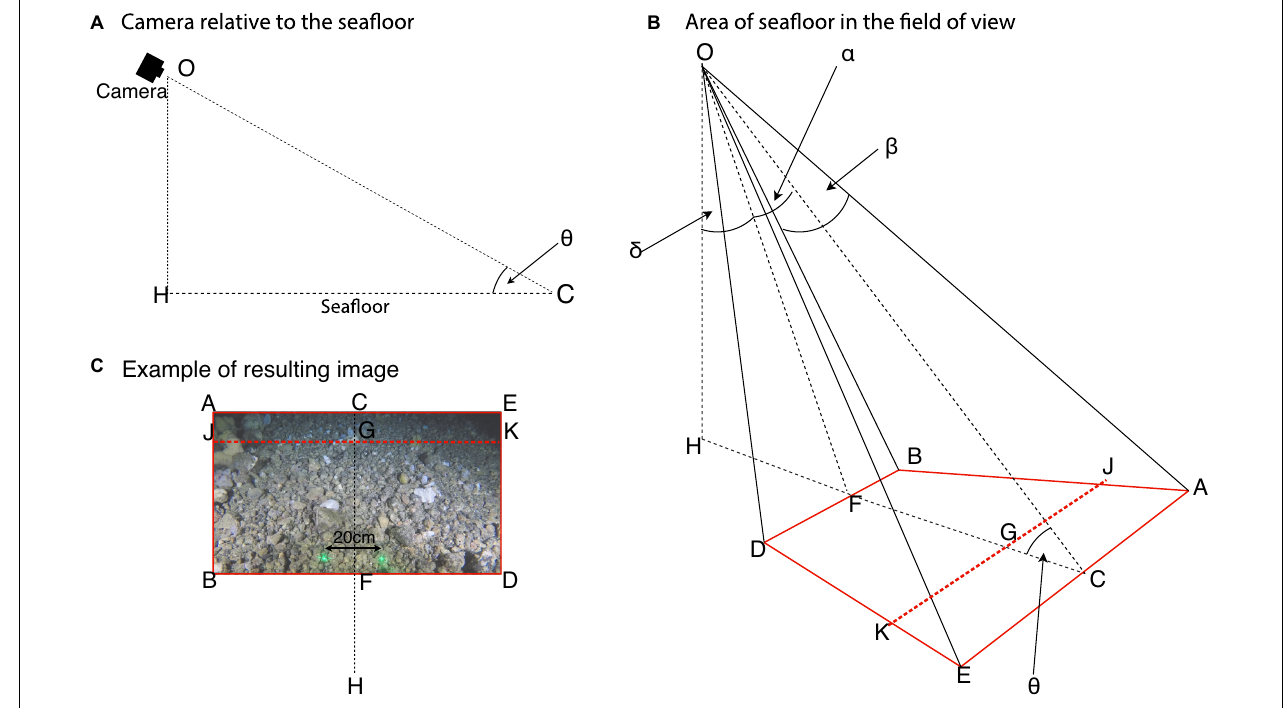
FIGURE 2 | Diagrammatic representation of the benthic video sled camera for determining the area of the field of view. (A) Shows the camera orientation relative to the seafloor. (B) Shows the camera position, aperture angles and area of seafloor ( ABDE ) in the camera’s FOV (red line); with a cut-off line JK to exclude the portion of the image unsuitable for analysis (red dashed line). (C) Shows an example image of the seafloor, in relation to (A,B) , for which the area JBDK is calculated and used in the estimation of fauna density. Adapted from: Nakajima et al.